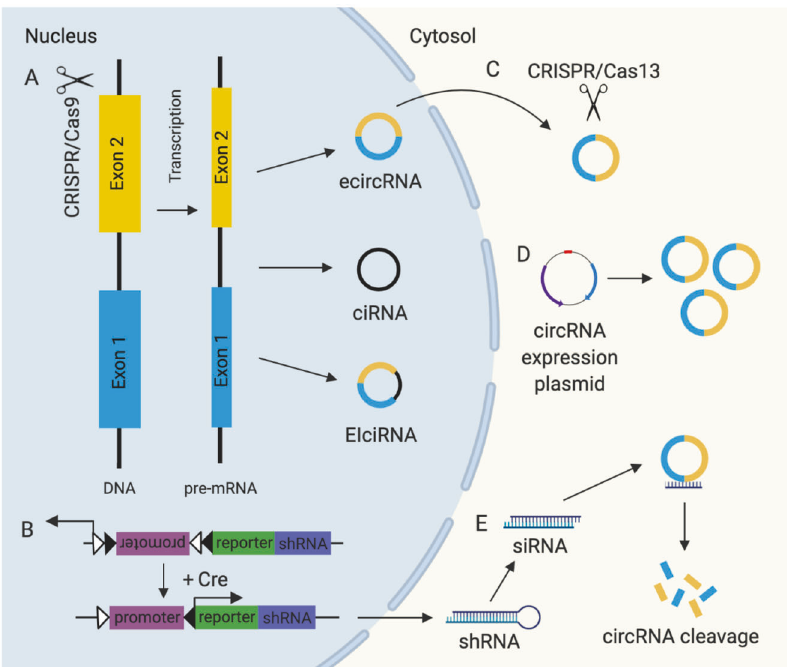
Fig. 2 Strategies used to study circular RNA (circRNA). A CRISPR/Cas9-mediated circRNA knockout via removal of intronic complementary sequence fl anking circularized exon involved in circRNA biogenesis. This system has also been used to target the entire gene locus and a transcription factor to knockout and knockdown circRNA, respectively (not shown). B Conditional circRNA knockdown mediated by a cre- dependent short hairpin RNA (shRNA), which is subsequently processed into short interfering RNA (siRNA) to induce circRNA cleavage. C CRISPR/Cas13-mediated circRNA knockdown directly targets the back-splice junction of circRNAs to induce circRNA cleavage. D CircRNA expression plasmid leads to circRNA overexpression. E siRNA/shRNA targeting the back-splice junction of circRNAs induces circRNA